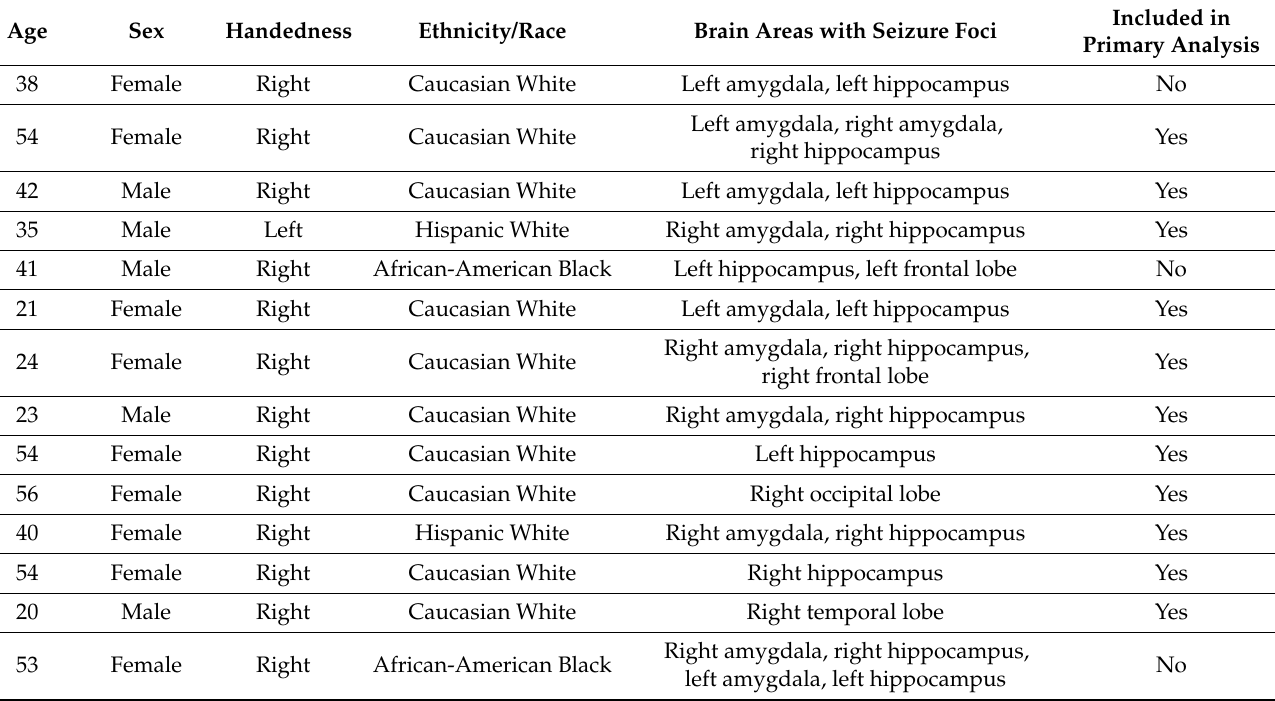
Table A1. Characteristics and clinically identified seizure foci for all subjects ( n = 14). Note the three subjects who were excluded from the primary analysis.